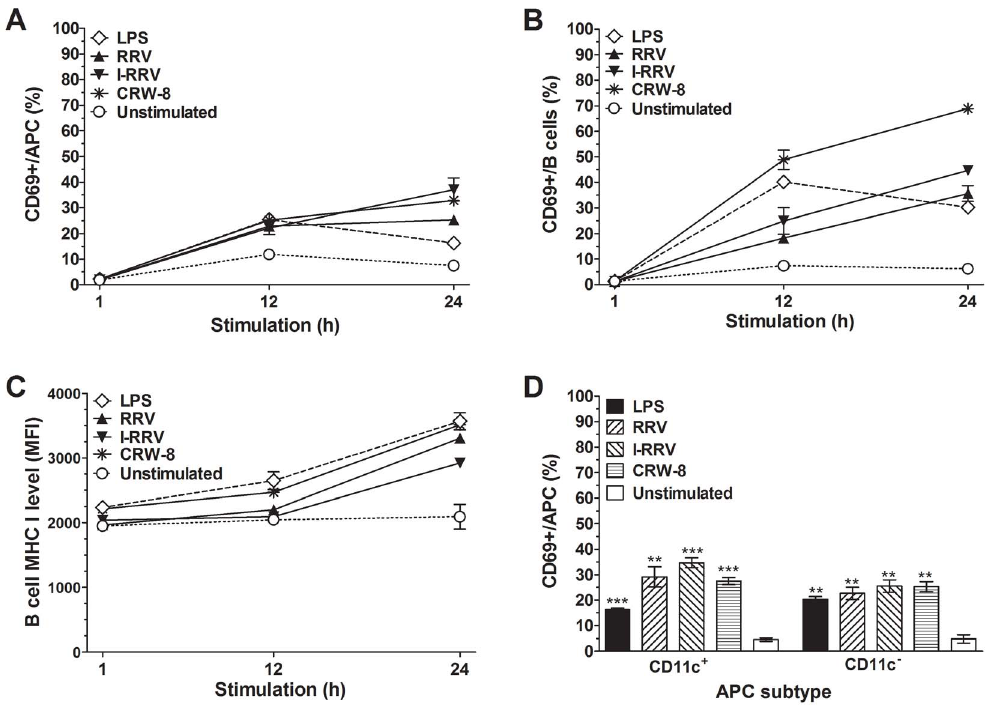
Figure 1. Rotavirus simulation of splenocytes induced APC and B cell activation. Cells (5 6 10 5 ) isolated from 12 week-old naive female NOD mice were cultured in the presence of 100 ng/ml LPS, RRV, I-RRV, CRW-8 or left unstimulated. The proportions of activated (CD69 + ) live cells at 1 h, 12 h and 24 h after treatment were determined for (A) APC (CD3 2 CD19 2 MHCII + ) and (B) B cells (CD3 2 CD19 + ). (C) Surface MHC I level (mean fluorescence intensity) on B cells at 1 h, 12 h and 24 h of stimulation. (D) Proportions of CD11c + APCs and CD11c 2 APCs expressing CD69 at 24 h after stimulation. Data are derived from one experiment and are representative of two independent experiments. Error bars indicate the mean 6 SEM of 3 replicates. ** p , 0.01 and *** p , 0.001 compared with the respective unstimulated